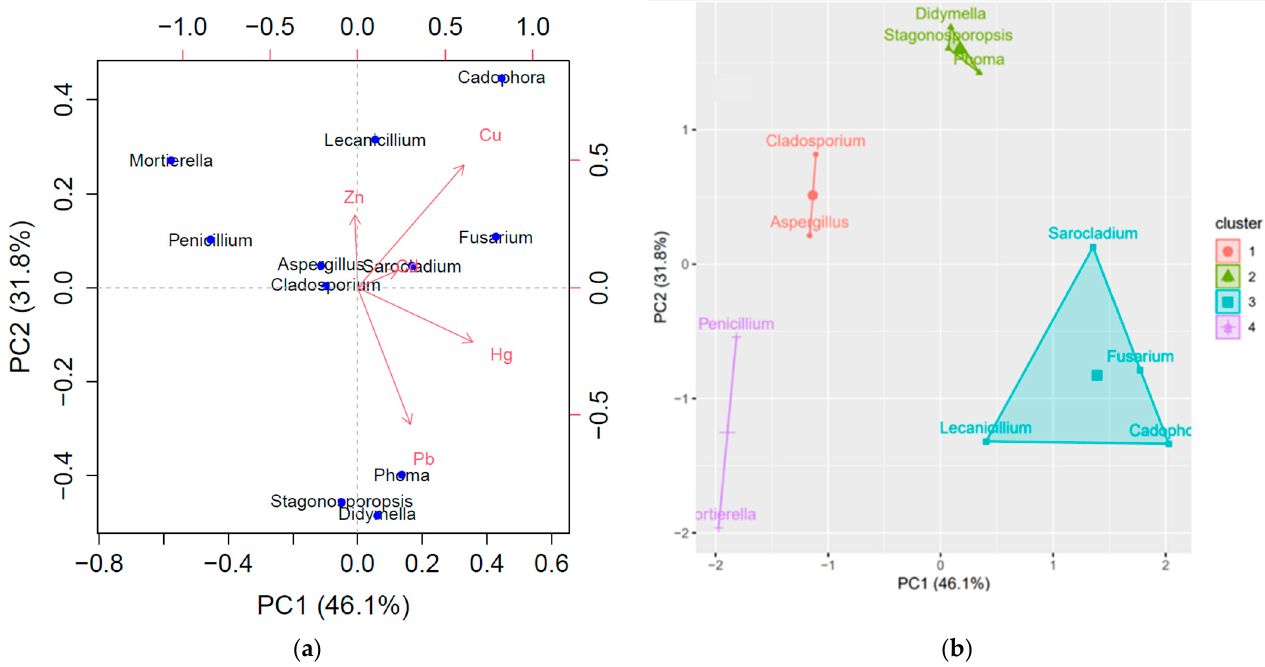
Figure 3. ( a ) Principal component (PC) analysis biplot and ( b ) k-means cluster plot, using the first two principal component scores, applied to the tolerance indices mean of each genus.